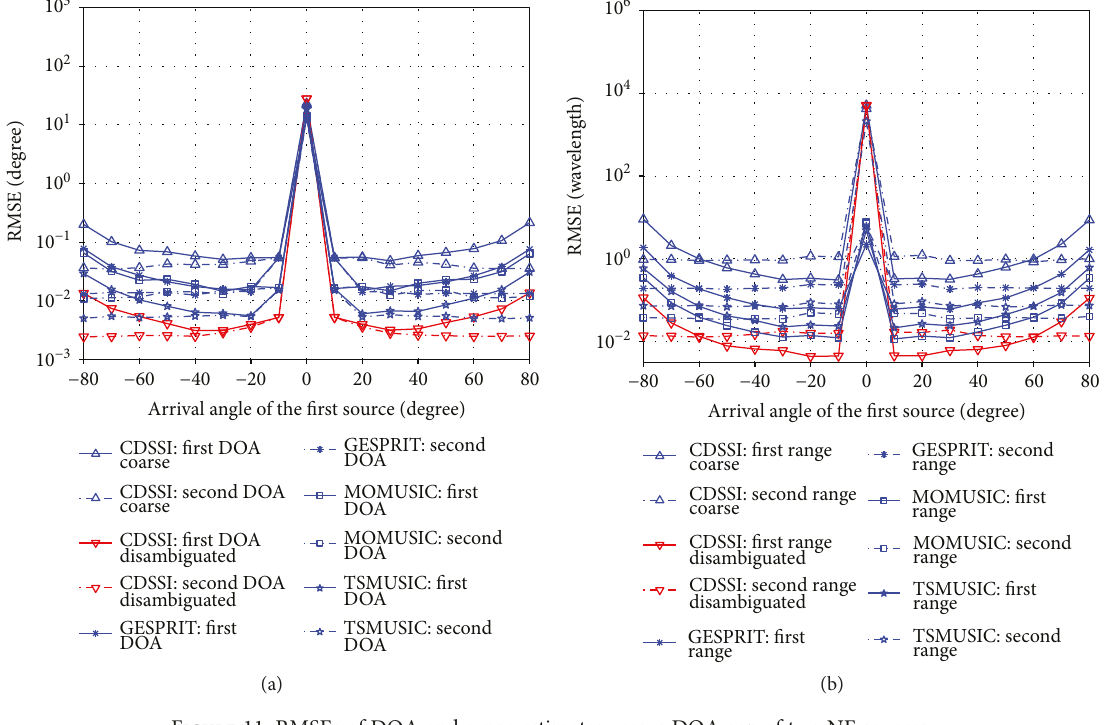
Figure 11: RMSEs of DOA and range estimates versus DOA gap of two NF sources.